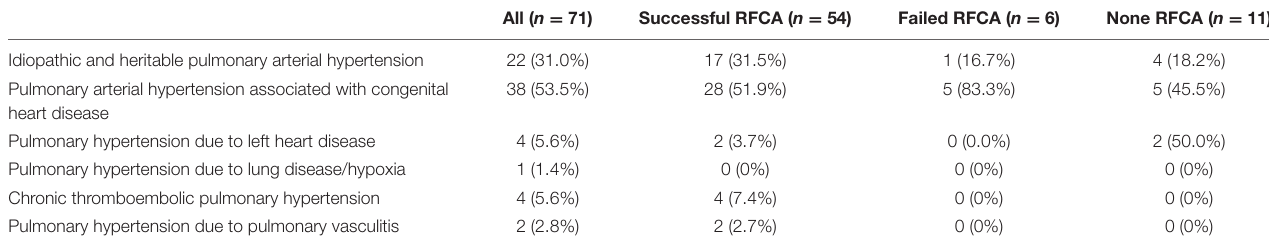
TABLE 2 | Classification of pulmonary hypertension among the study population.